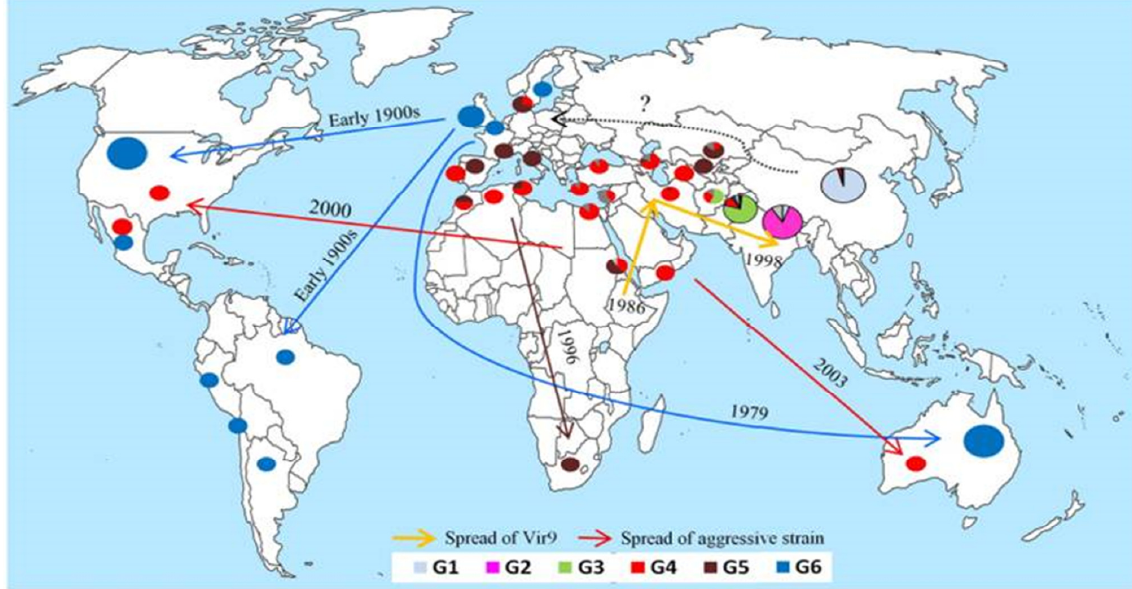
Fig. 6. Origin and migration routes of recently emerged populations of wheat yellow rust pathogen identified or confirmed through population genetic analyses of a worldwide representative set of isolates (Ali et al. ,